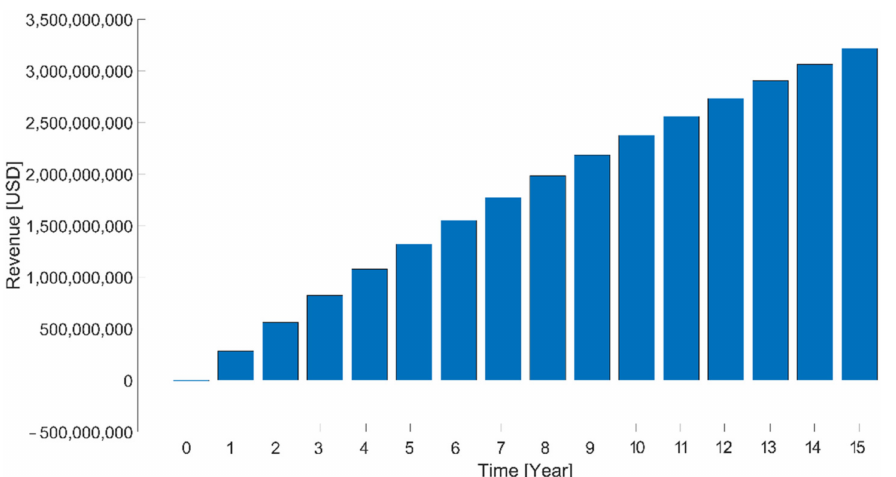
Figure 6. Free Cash Flow for Base Case